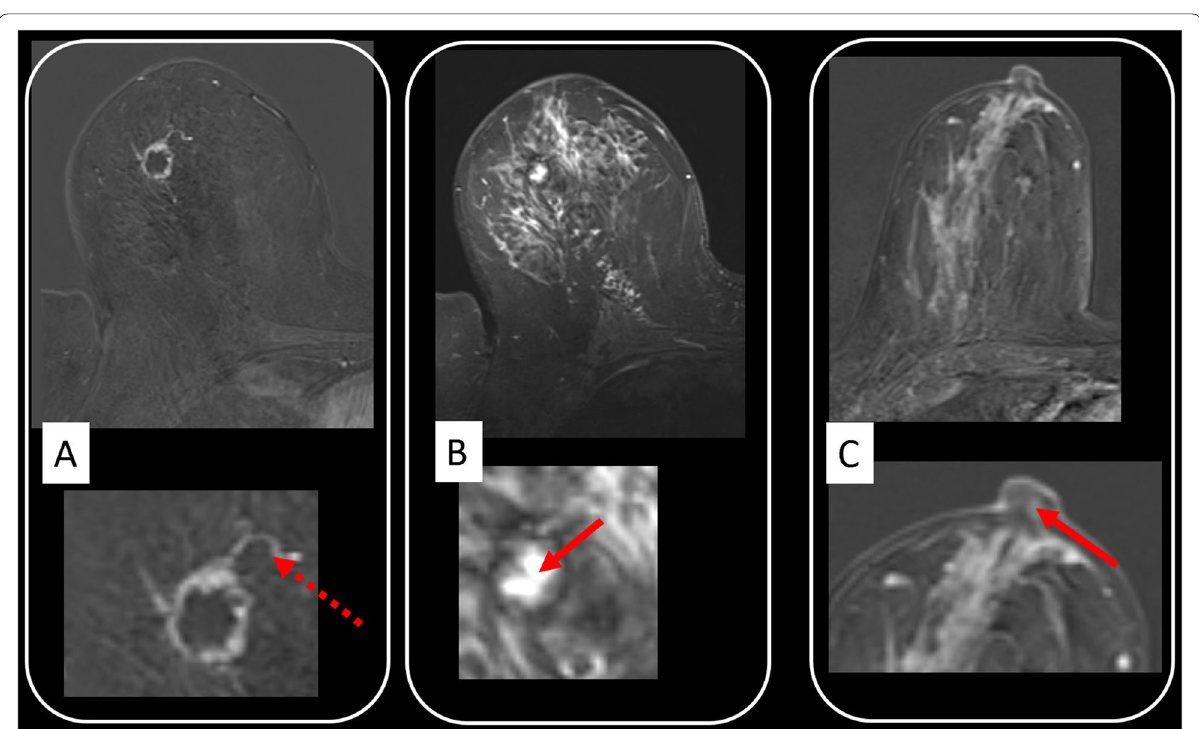
Fig. 6 Selected semantic parameters with known biological correlates. They can be readily implemented into clinical practice. Rim enhancement ( A ) was among the first morphologic parameters reported in the literature and reflects an aggressive cancers phenotype. This is also suggested by the adjacent vessel sign ( A , magnification: dotted red arrow) [50]. Rim enhancement is thought to reflect central hypovascularity due to connective tissue, fibrosis, and/or necrosis. Necrosis sign ( B ) specifically depicts central colliquative (liquid) necrosis ( B , magnification: full red arrow), characterised by a high signal intensity on T2‑weighted images within the centre of the tumour. Invasion of the cancer into the nipple areolar complex is related to poor outcome. The semantic criterion described as “destruction of nipple line” ( C ) is best depicted on DCE images ( C , magnification: red arrow). Further details including diagnostic performance of semantic parameters are provided in Table